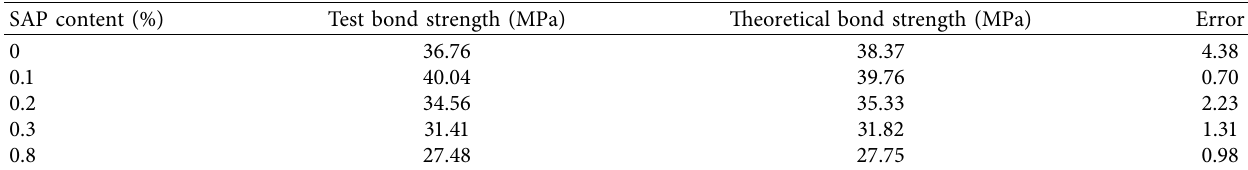
Figure 9. Then the mean of the five numbers 0.1892 was